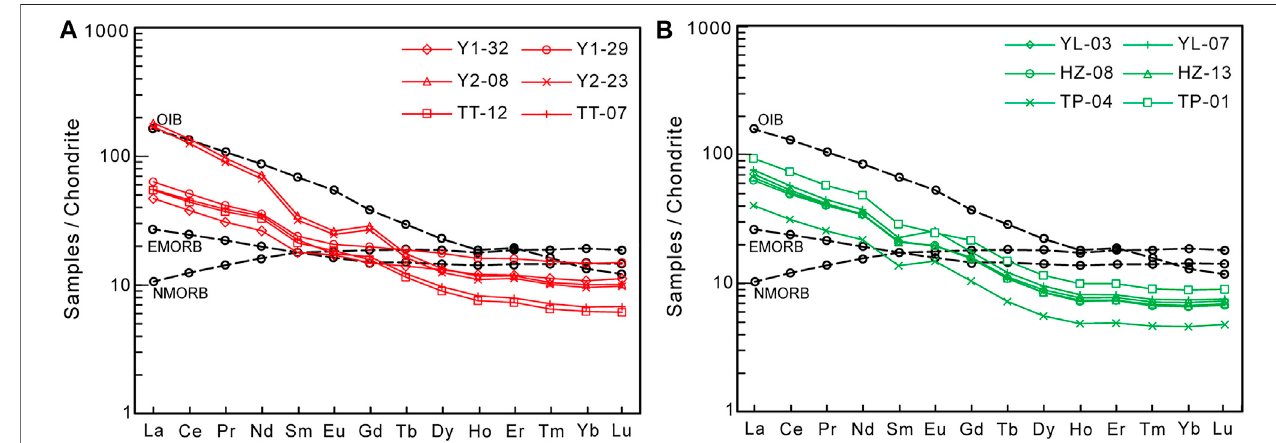
FIGURE 9 | Chondrite-normalized whole-rock REE patterns for the Huaibei-Linhuan intrusive rock samples: (A) gabbro-dolerite; (B) (quartz-)diorite and granodiorite. Chondrite normalizing values are from Sun and McDonough (1989).